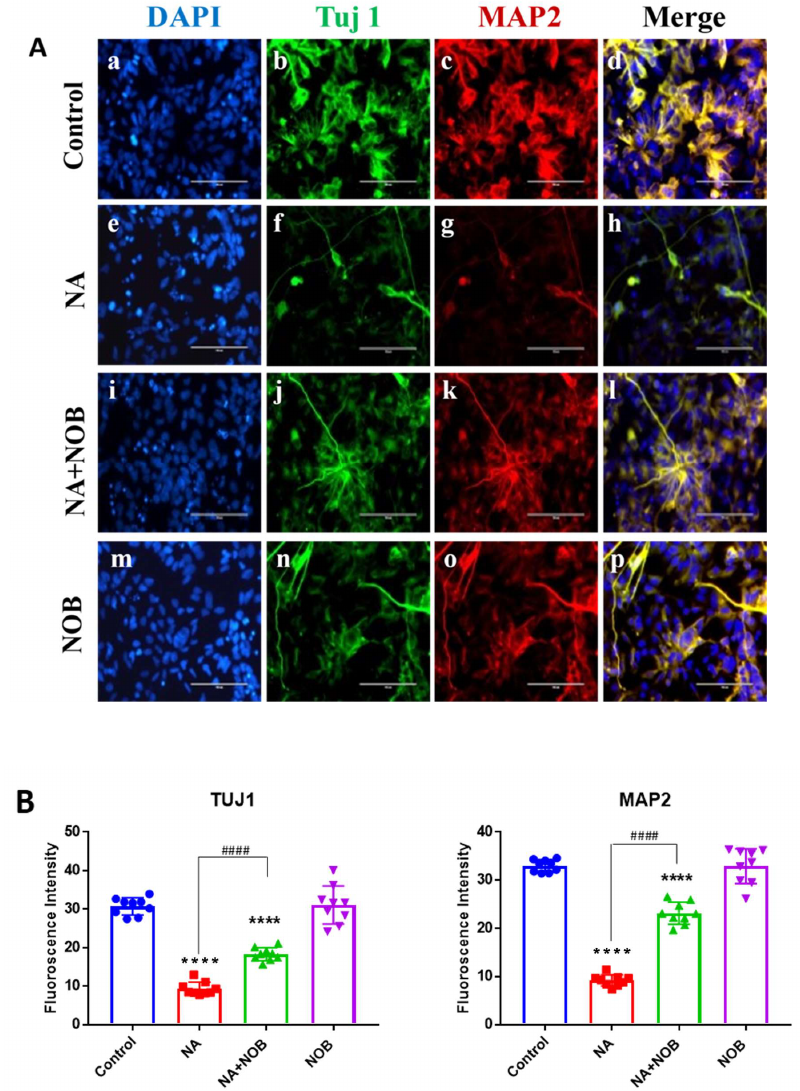
Figure 6. Effect of NA and NOB on hNPCs neuronal markers. Figure ( A ) Representative immunocytochemistry (ICC) images of hNPCs, depicting the expression of the functional neuronal marker genes TUJ1 and MAP2 of ( d ) Control or unexposed cells, ( h ) NA-exposed cells, ( l ) NA and NOB co-exposed group, and ( p ) NOB exposed cells; Images were taken using an Invitrogen EVOS FL fluorescence microscope. Scale bar, 100 μM. ( B ) Fluorescent intensity was calculated by ImageJ software, and images are represented in graph format.